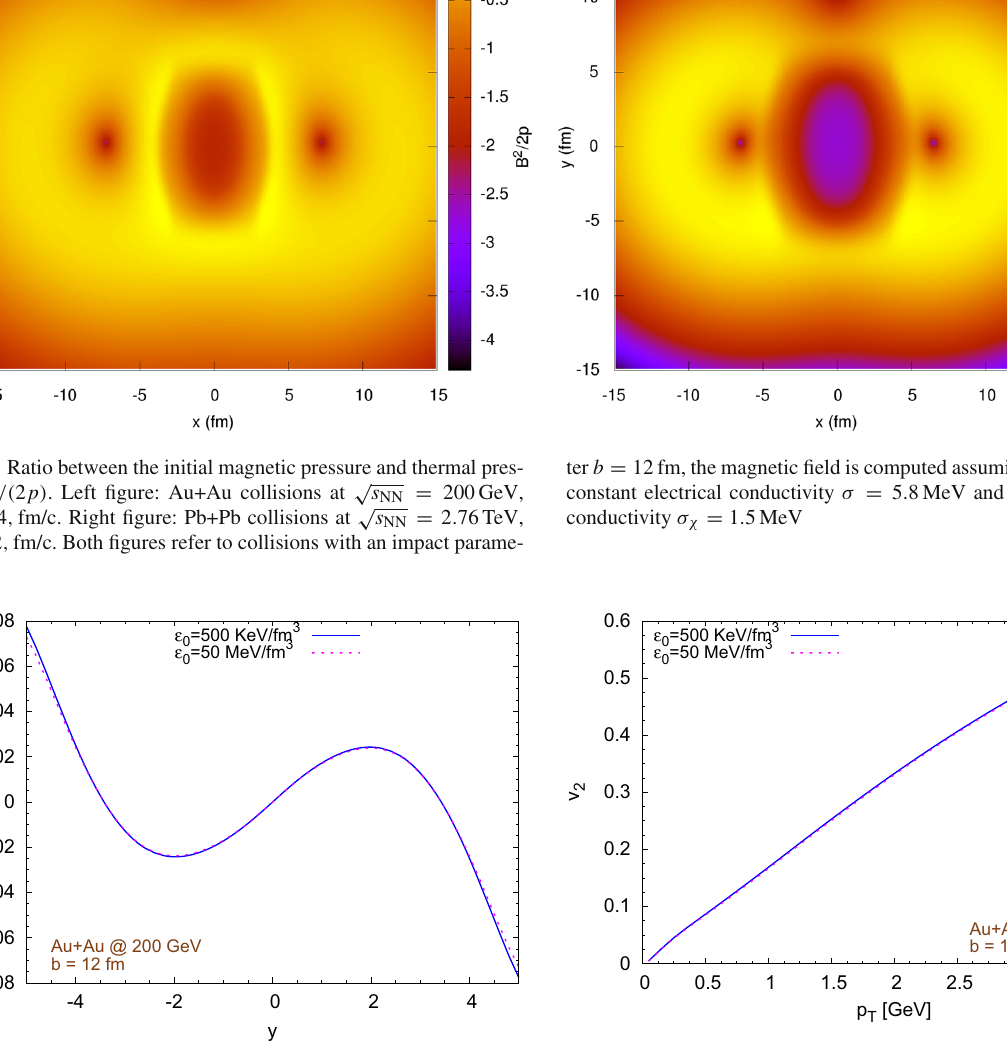
v n compared to the case when a much smaller value is